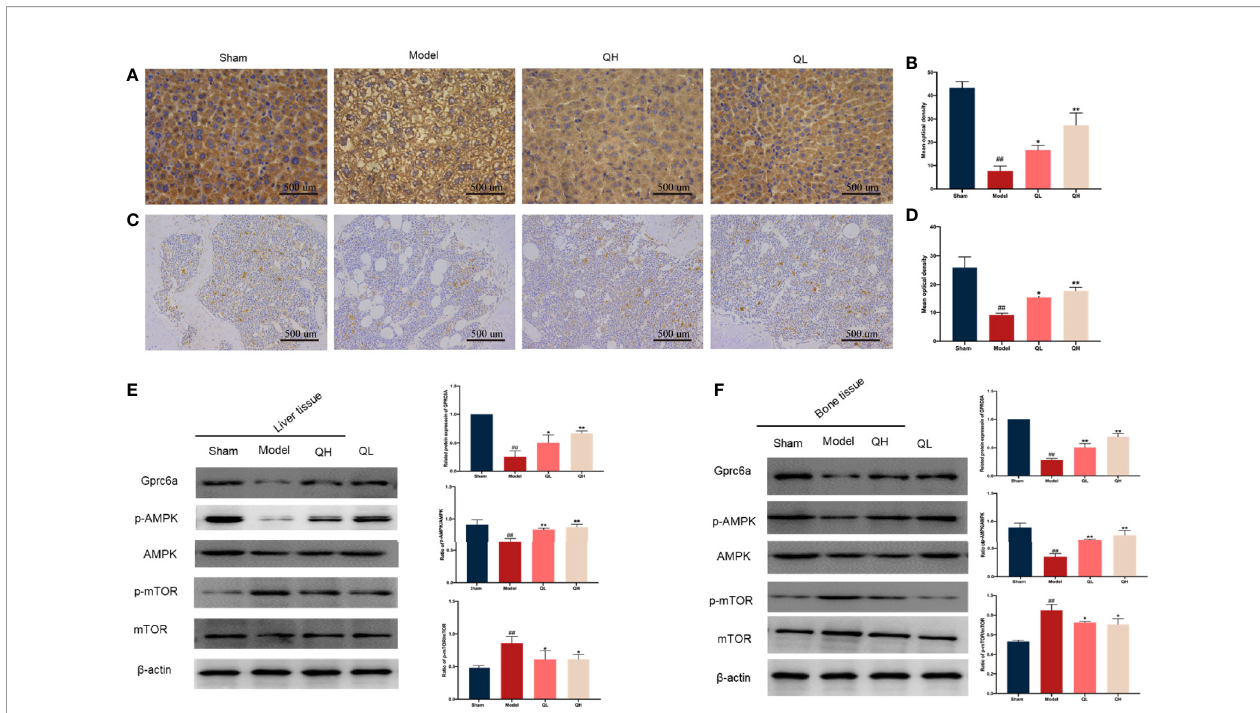
FIGURE 9 | Effects of quercetin on the GPRC6A/AMPK/mTOR signaling pathway in mice that underwent orchiectomy. Immunohistochemical staining for GPCR6A and staining quanti fi cation in liver (A, B) and (C, D) . Expression of GPCR6A in the liver (E) and bone (F) evaluated by western blotting assay (on the left) and semi- quantitative analysis (on the right). ## p< 0.01 vs. sham group; * p< 0.05, ** p< 0.01 vs. model